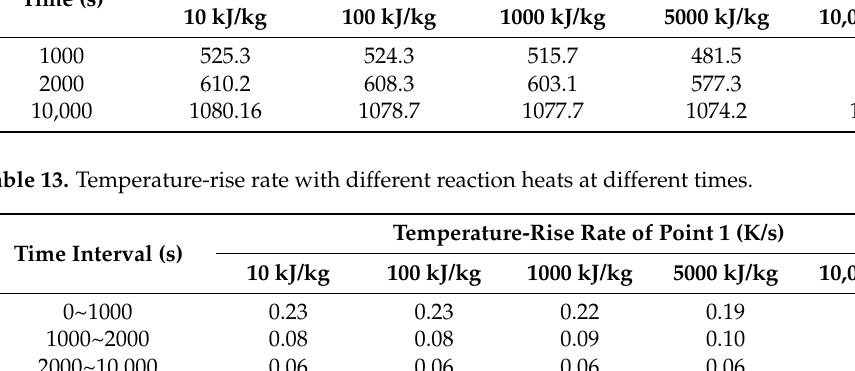
Figure 18. Temperature variation over time with different reaction heats. Table 12. Temperature with different reaction heats at different times. Time (s)